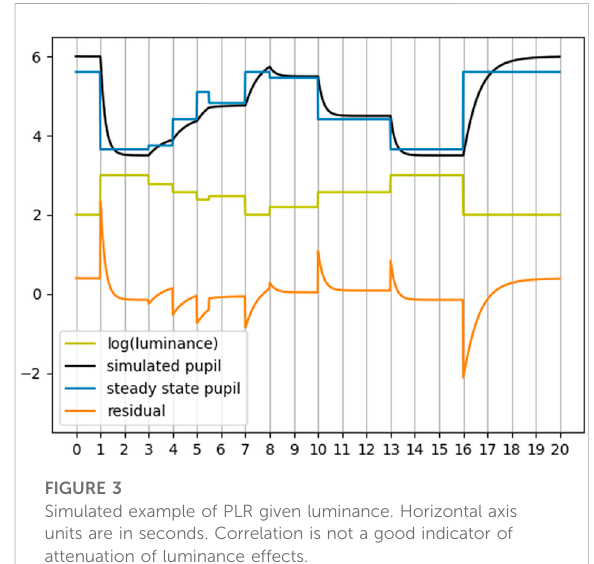
FIGURE 3 Simulated example of PLR given luminance. Horizontal axis units are in seconds. Correlation is not a good indicator of attenuation of luminance